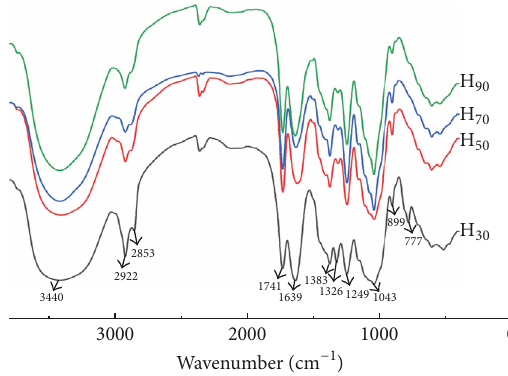
Figure 2: FT-IR spectra of DMSO-extracted fractions H 30 , H 50 , H 70 , and H 90